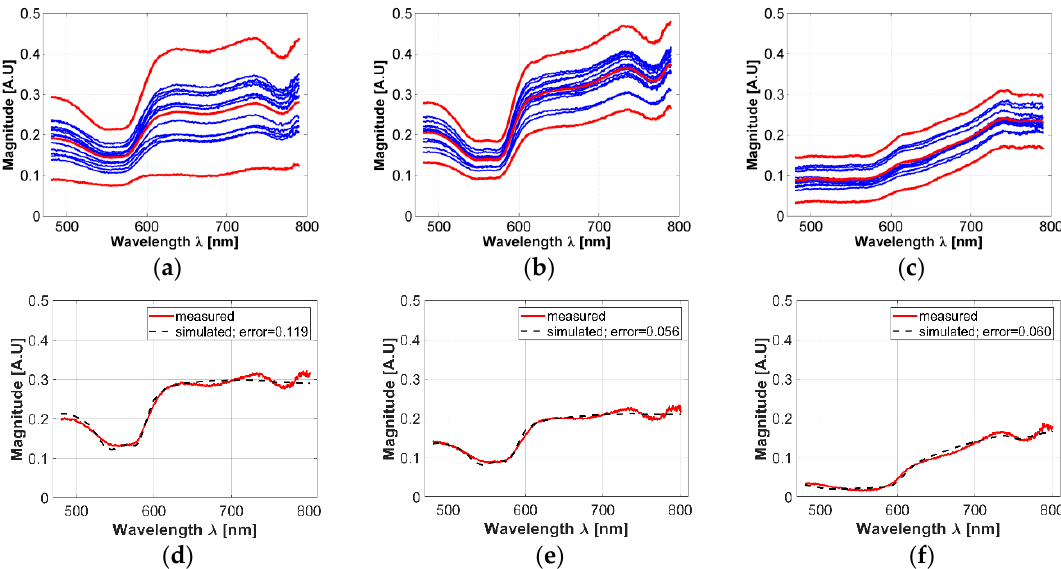
Figure 4. ( a – c ): examples of acceptance range values obtained from the acquired spectra and calculated with the 3-sigma rule. ( a ) An acceptance range for healthy skin spectra; ( b ) an acceptance range obtained from the ulcer’s border spectra; ( c ) an acceptance range obtained from ulcer’s center spectra. Light-red color line corresponds to the mean spectra. Bold red-colored lines correspond to the spectra obtained from the 3 sigma rule. Blue lines correspond to acquired spectra inside the acceptance range. ( d – f ): examples of simulated values after the fitting process in: ( d ) healthy skin, ( e ) ulcer’s border, and ( f ) ulcer’s center spectra.